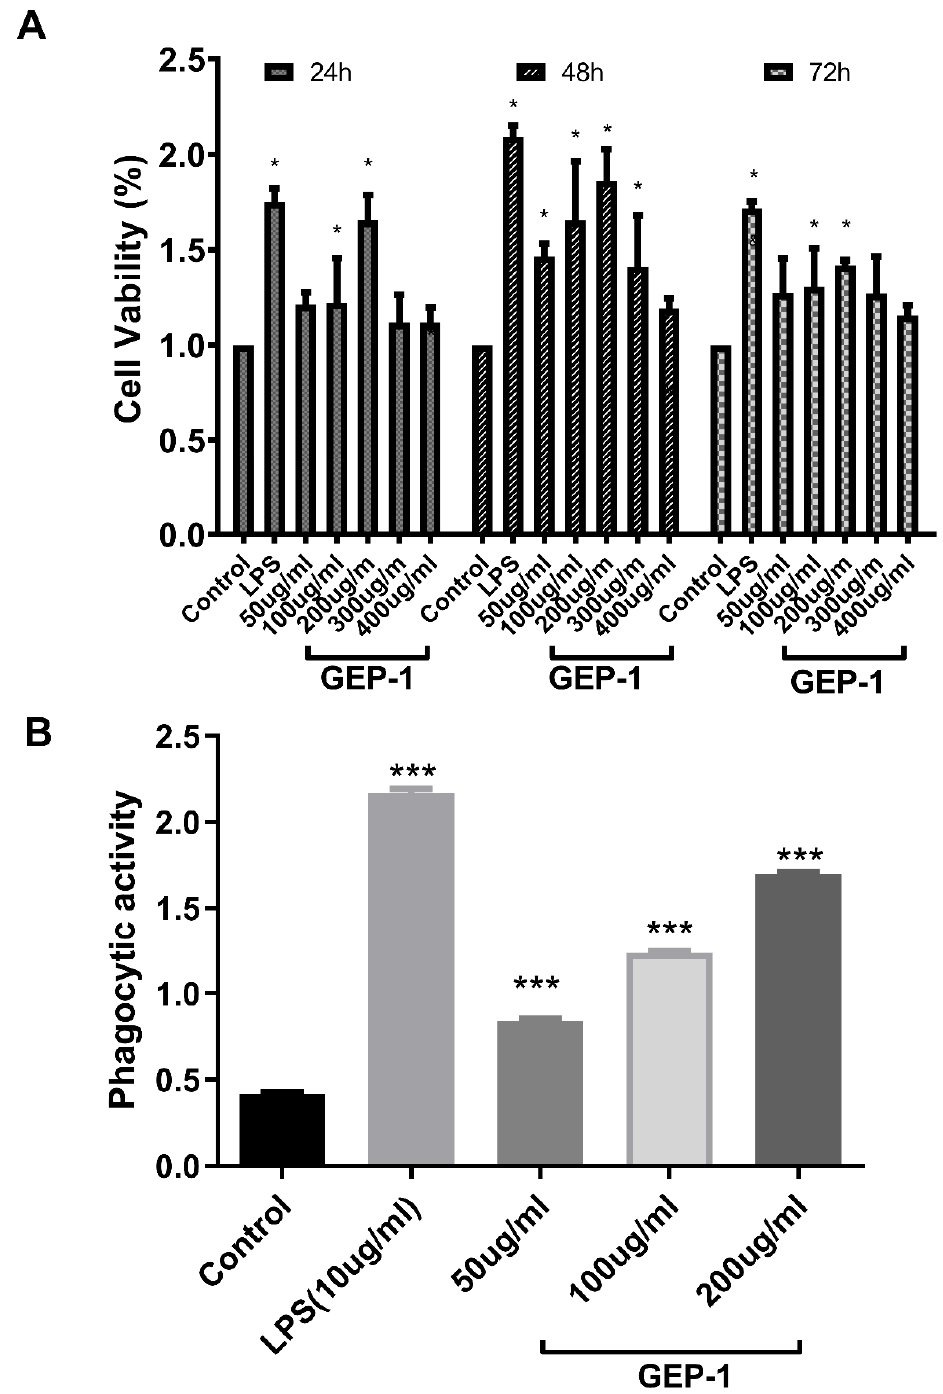
Figure 4. Effects of GEP-1 on cell proliferation ( A ) and phagocytic activities ( B ). Control, cells without treatment; LPS, LPS group, cells treated with 10 µ g/mL LPS alone; GEP-1 groups, cells treated with GEP-1 at concentrations ranging from 50 to 400 µ g/mL. The symbol “*” represents a significant difference compared with the control group ( p < 0.05). “***” represents a significant difference compared with the control group ( p < 0.01).